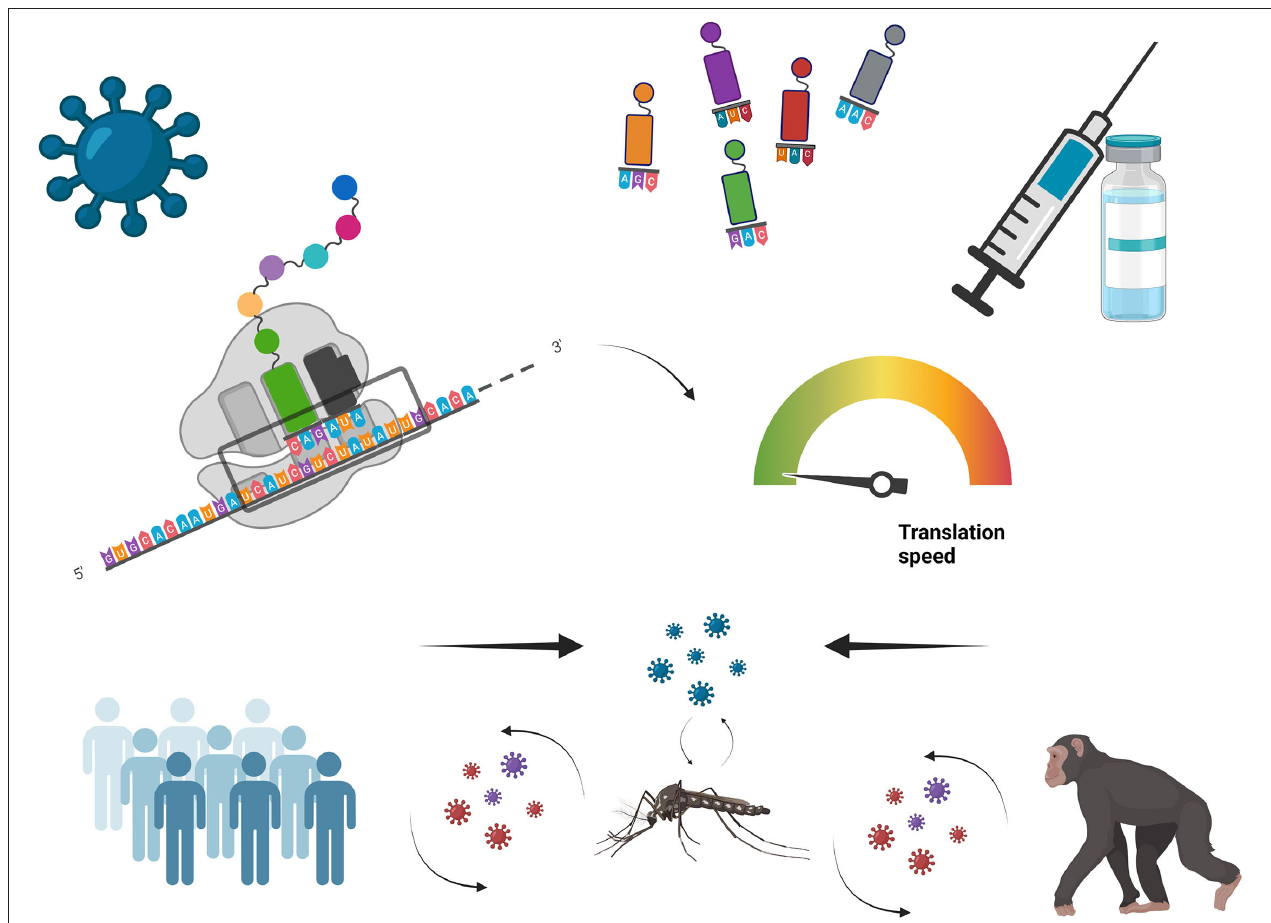
FIGURE 1 | Viral vaccines design based on genome